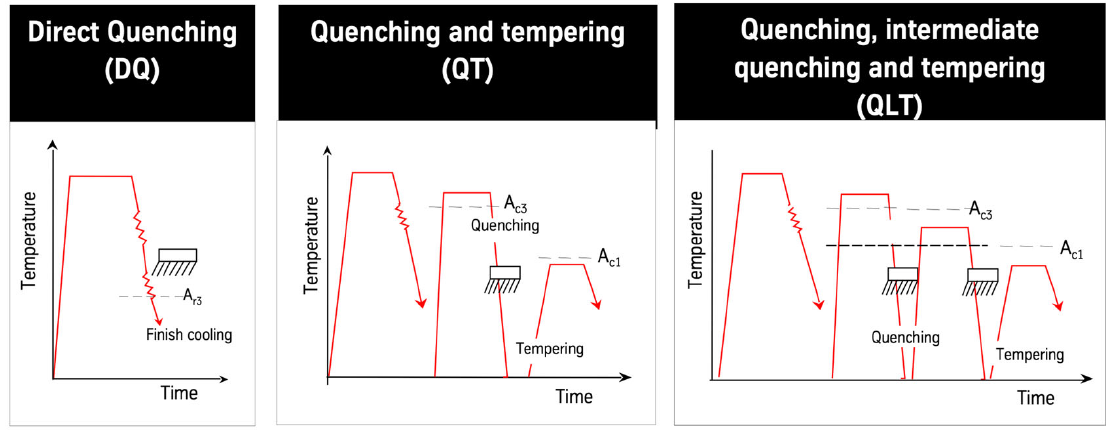
Figure 18. Heat treatment variants for the production of cryogenic steels with 5–9 wt.% Ni.